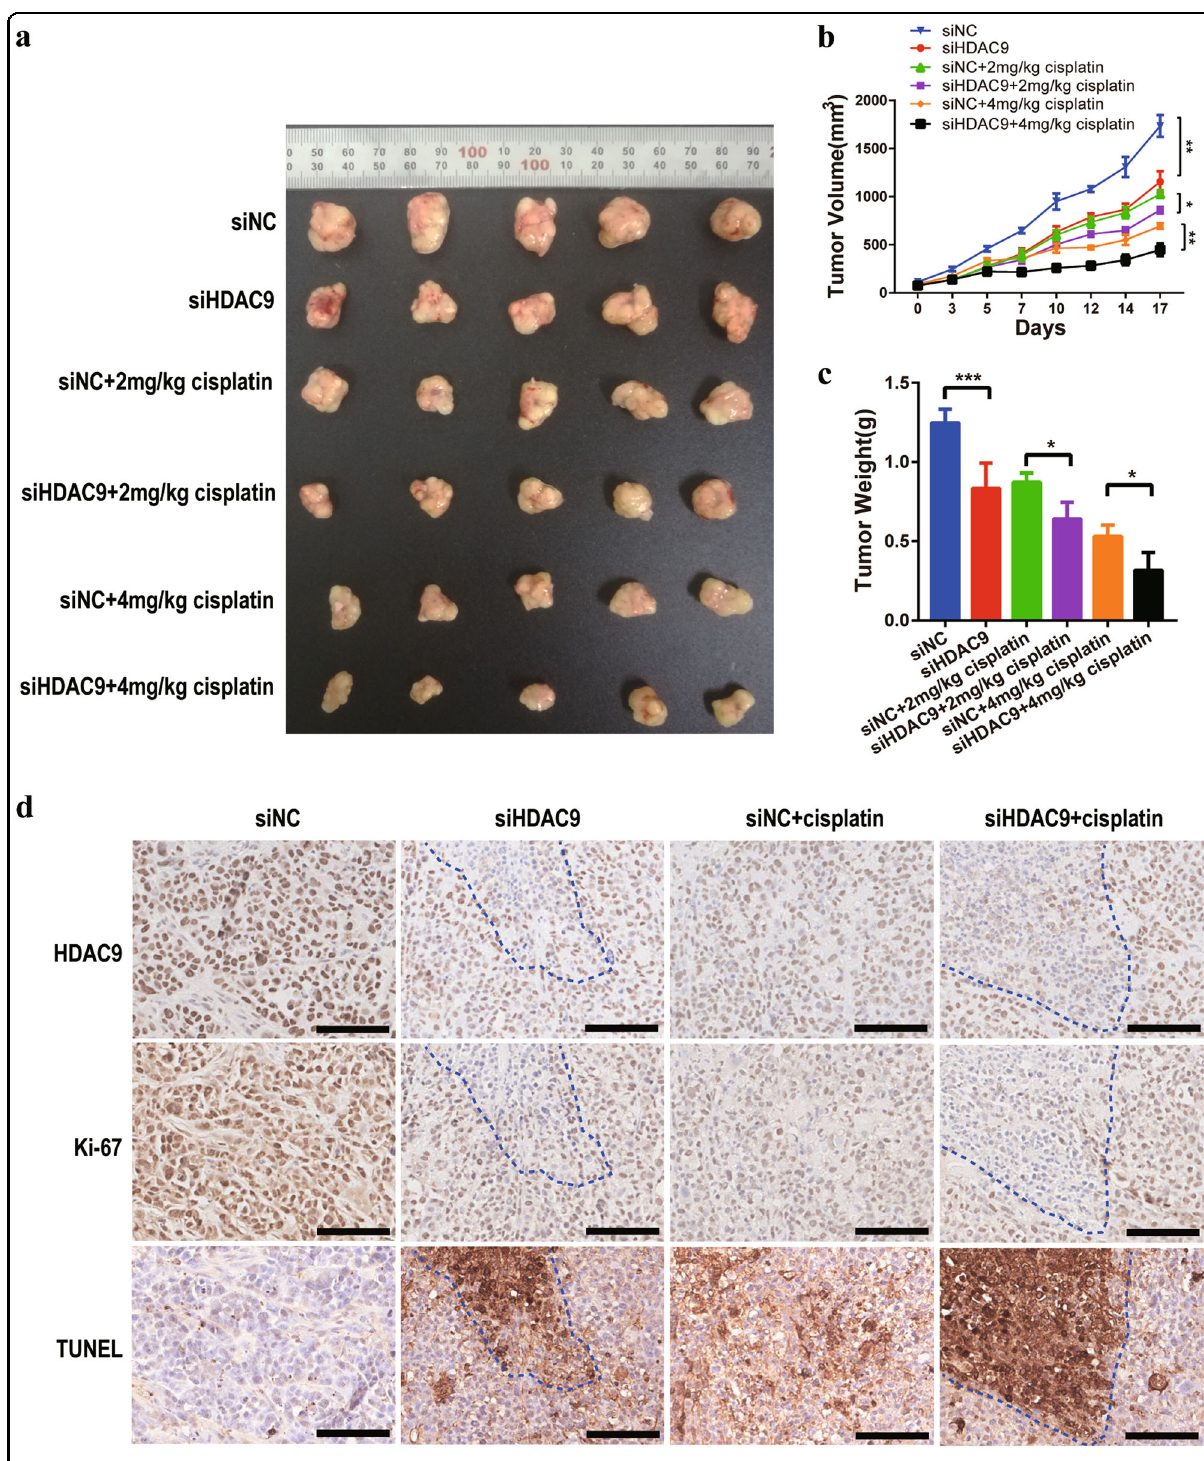
Fig. 8 HDAC9 inhibition enhanced the effect of cisplatin on GC tumor suppression. a Knockdown of HDAC9 in SGC-7901 cells resulted in reduced subcutaneous tumorigenic ability and enhanced the antitumor effect of cisplatin in nude mice. b The tumor volumes were monitored three times weekly. The combination of siHDAC9 and cisplatin showed greater antitumor effect than each single-agent treatment. c The dissected xenograft tumors were weighed at the end of treatment. d HDAC9 expression and cell proliferation and apoptosis were assessed by HDAC9 and Ki- 67 immunohistochemical staining and a TUNEL assay using serial sections. The HDAC9-negative area denoted by the dotted line indicates the location of siHDAC9 injection. Scale bars = 100 μ m. The error bars indicate the means ± SDs; * p < 0.05, ** p < 0.01, *** p < 0.001 versus the control